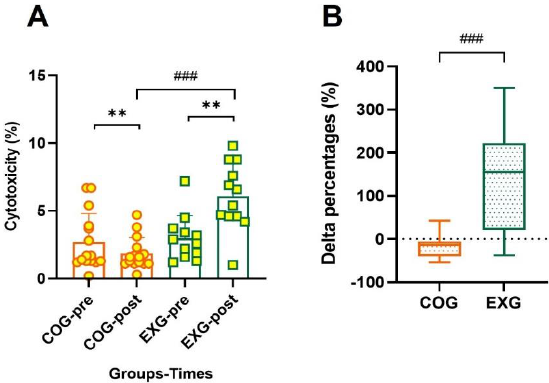
Figure 8. Cytotoxicity increases in the ovarian cancer survivors after 12 weeks of aerobic and re- sistance exercise. ( A ) Cytotoxic values in the control group (COG) and in the exercise group (EXG). ( B ) Percentages of cytotoxicity analyzed as Δ% in both groups. All data are represented as means ± SD. p -values were calculated by Student’s t test or Mann– Whitney U test. For ( A ) to ( B ), these tests were performed independently at each time point; ### p < 0.001. p -values were calculated by Wilcoxon signed rank test. For ( A ), the test was performed dependently at each time point; ** p < 0.01.